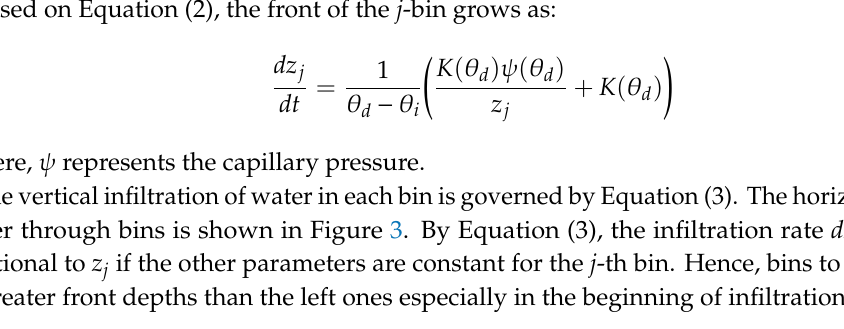
Figure 2. The infiltration in the Talbot–Ogden model.